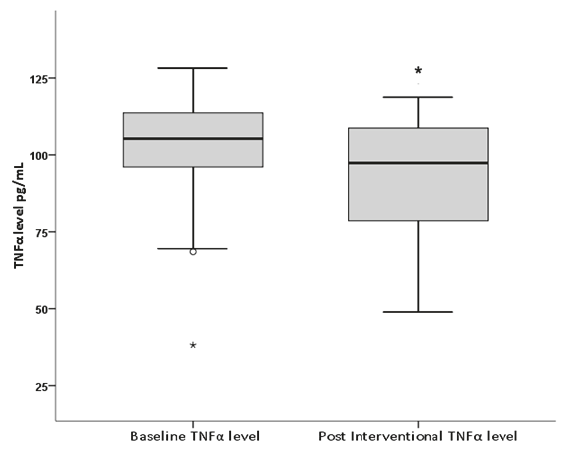
Figure 2: Effect of Gum Arabic intake on TNF level (P.V=0.05). ∗ indicates significant difference from baseline.